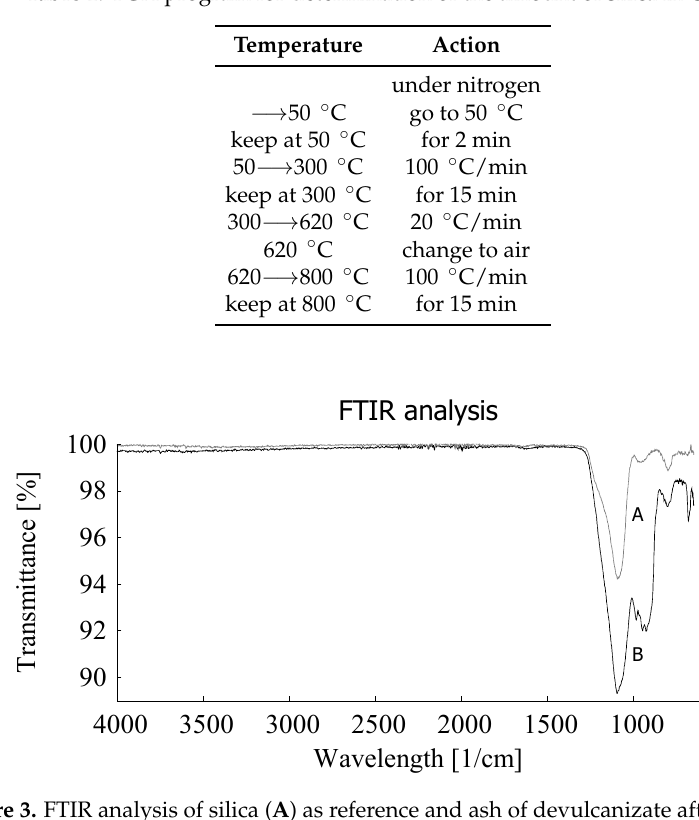
Table 1. TGA program for determination of the amount of silica in GTR.